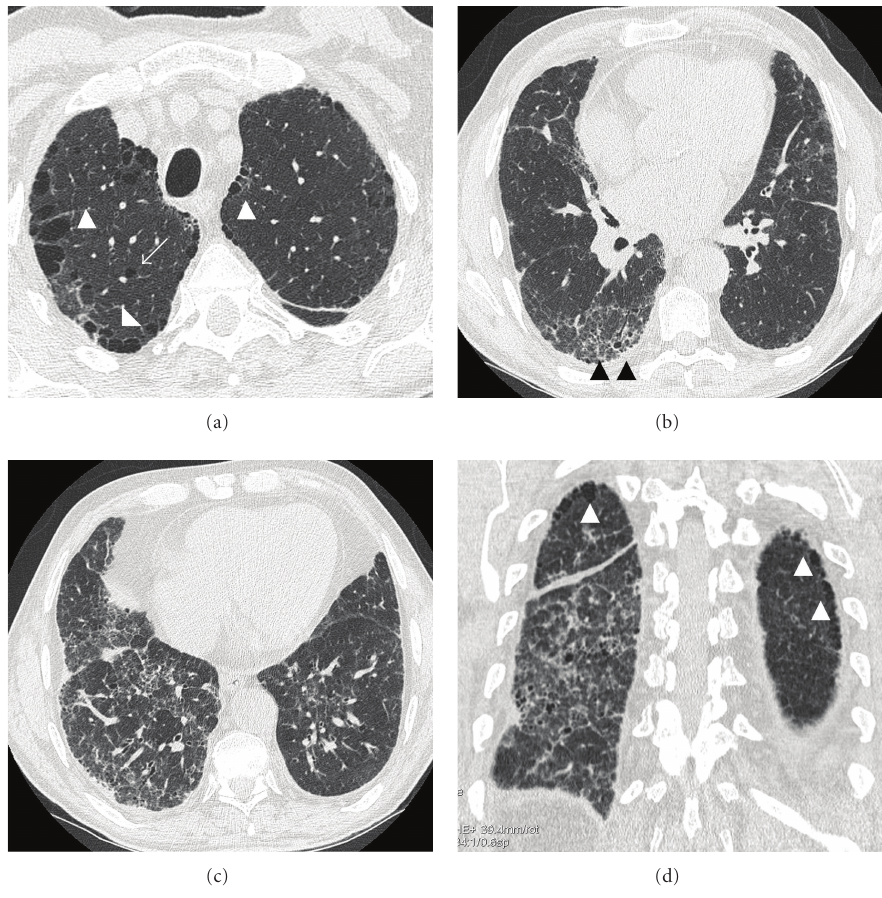
Figure 2: High-resolution computerized tomography (HRCT) of the same patient. (a) Presence of paraseptal emphysema and subpleural bullae (white arrowheads) and centrilobular emphysema (arrows) in both upper lobes. (b) Reticular interstitial disease with intralobular thickening and images of subpleural honeycombing and traction bronchiectasis (black arrowheads), (c) Reticular interstitial disease in middle and right lower lobes, with interlobular septal thickening, subpleural honeycombing, and traction bronchiectasis. (d) Coronal reconstruction in the posterior regions of both lungs: bilateral paraseptal emphysema (white arrowheads) and reticular interstitial disease and honeycombing in right lower